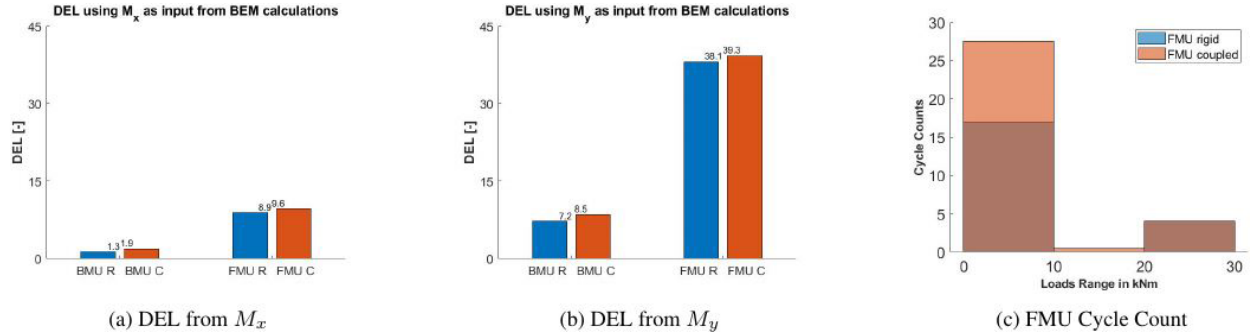
Figure 22. DEL calculation using BEM: results for M x in (a) and for M y in (b) . Comparison between rigid (R) and coupled (C). Cycle count in comparison to load ranges for FMU using as input M x in (c)